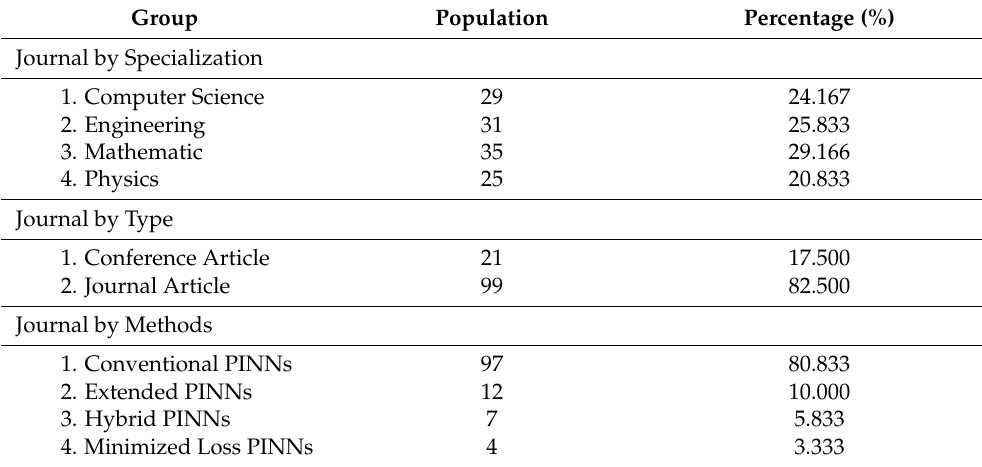
Table 1. Quantitative study characteristics.